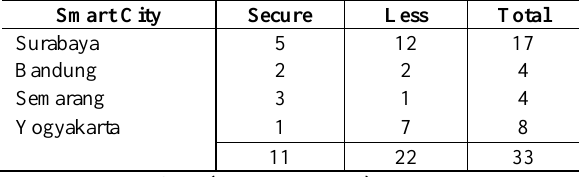
Table 1. The security level of web-based smart city applications